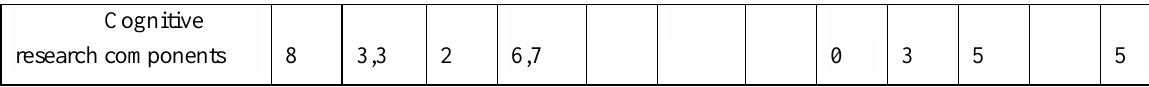
Table 5. Research methodology of development of competence-research components of a multi- level nature. Level of research competence in